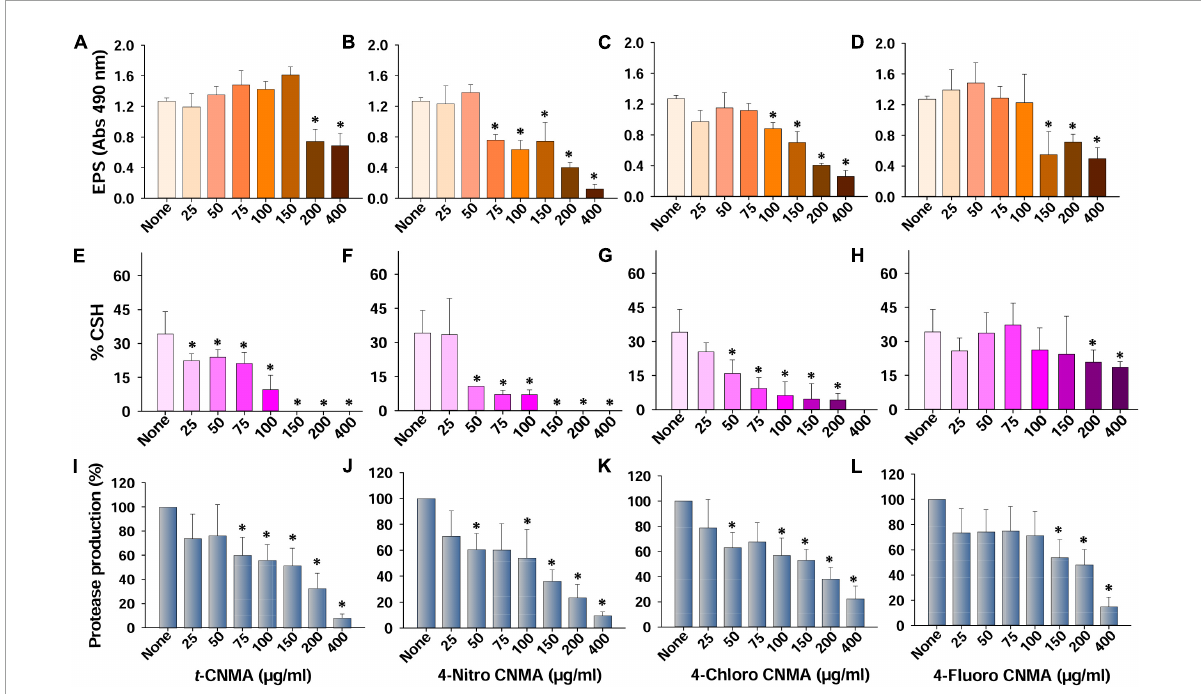
FIGURE4 Production of virulence factors and their inhibition by t -CNMA and its 4-nitro, 4-chloro, and 4-fluoro CNMA derivatives. Effects on EPS production (A–D) , cell surface hydrophobicity (E–H) , and extracellular protease production (I–L) . “*” denotes a significant difference by the two-tailed t -test ( P ≤